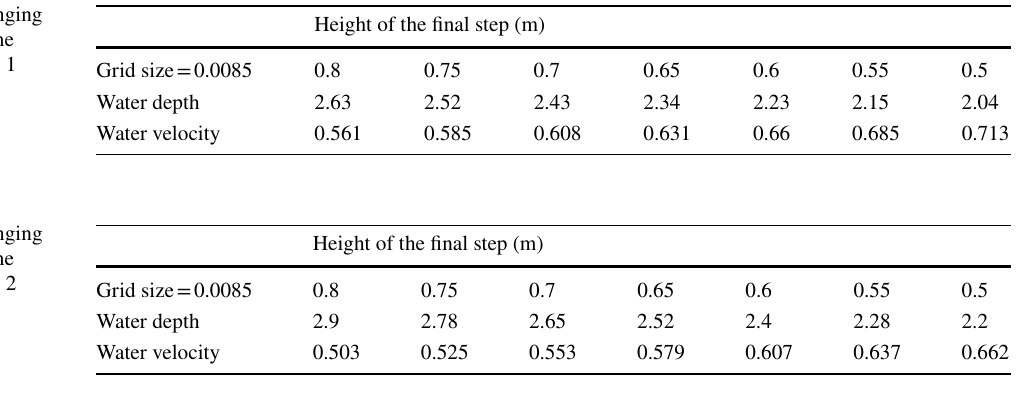
Fig. 7 Comparison of the water flow profiles in the numerical model with laboratory